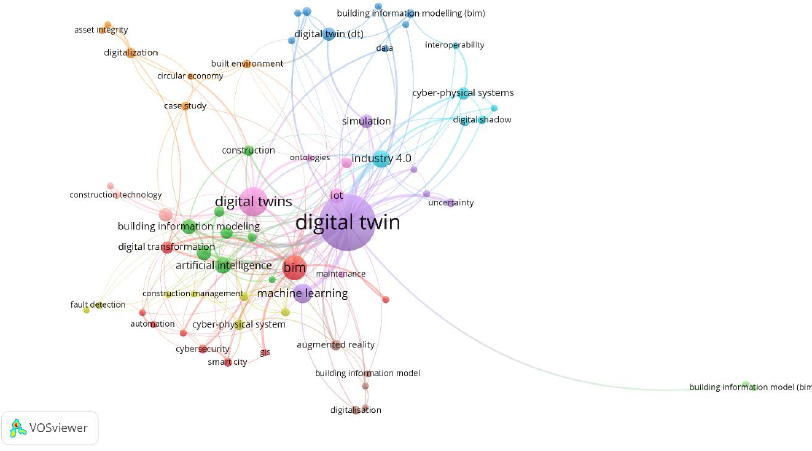
Figure 2. Keywords co-occurrence network of DTs in construction industry research.